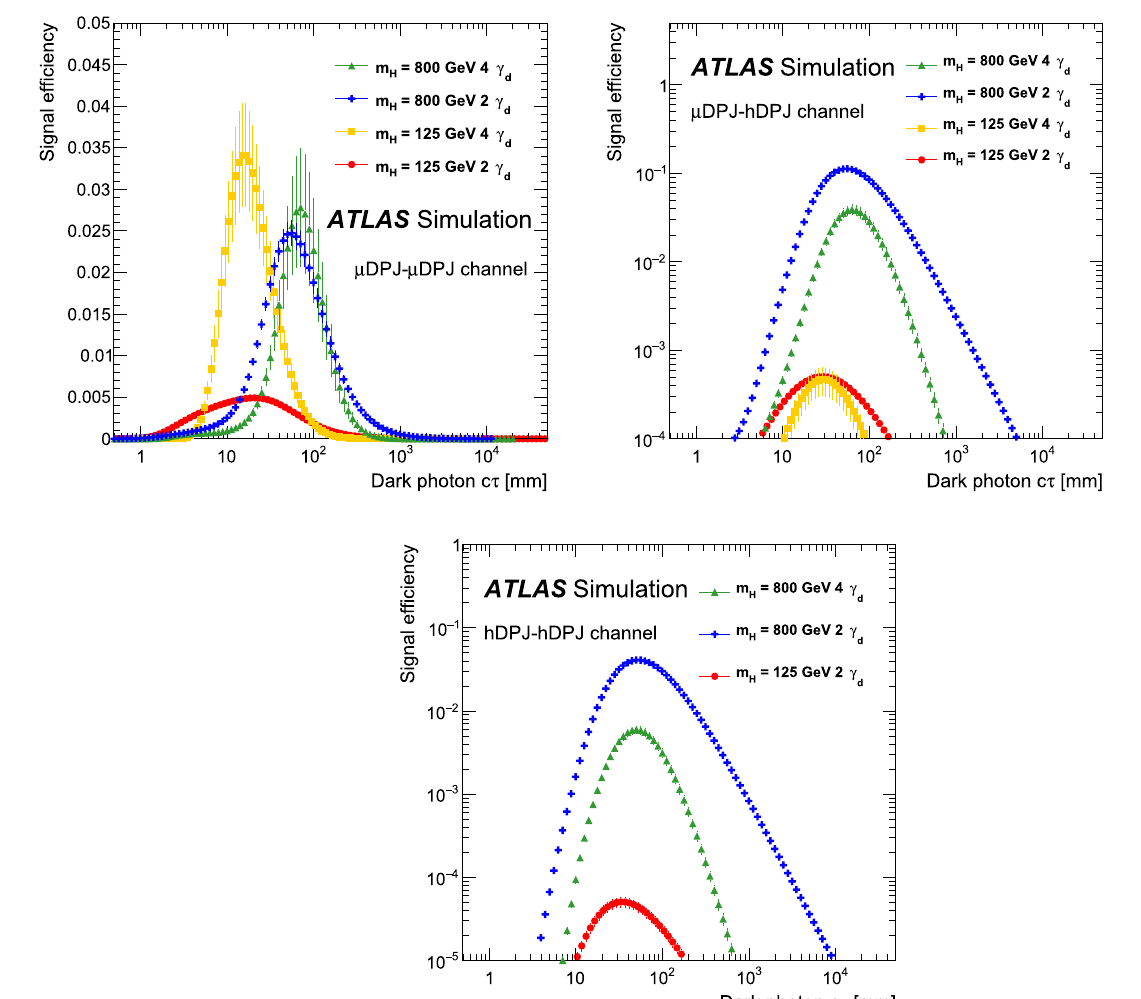
Fig. 4 Extrapolated signal efficiencies as a function of proper decay length of the γ d for the H → 2 γ d + X and H → 4 γ d + X processes and for the three different channels: μ DPJ– μ DPJ (left), μ DPJ–hDPJ (right) and hDPJ–hDPJ (bottom). The signal efficiency in the hDPJ–